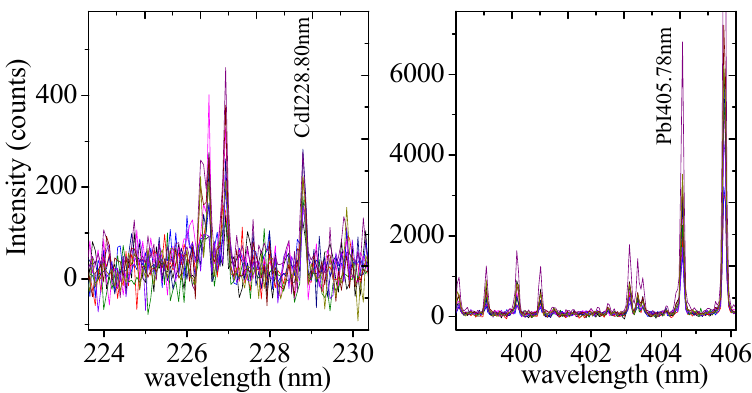
Figure 3. Spectra of Cd and Pb in leaves.